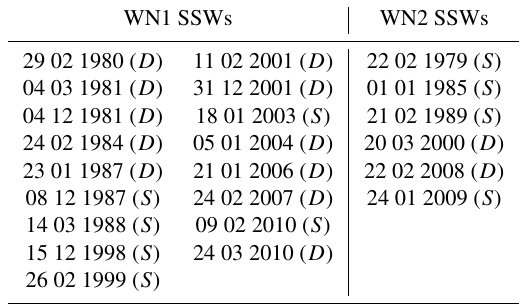
Table 1. Classification of the common SSWs into WN1 and WN2 events in the comparison period. (In brackets the S/D classifica-